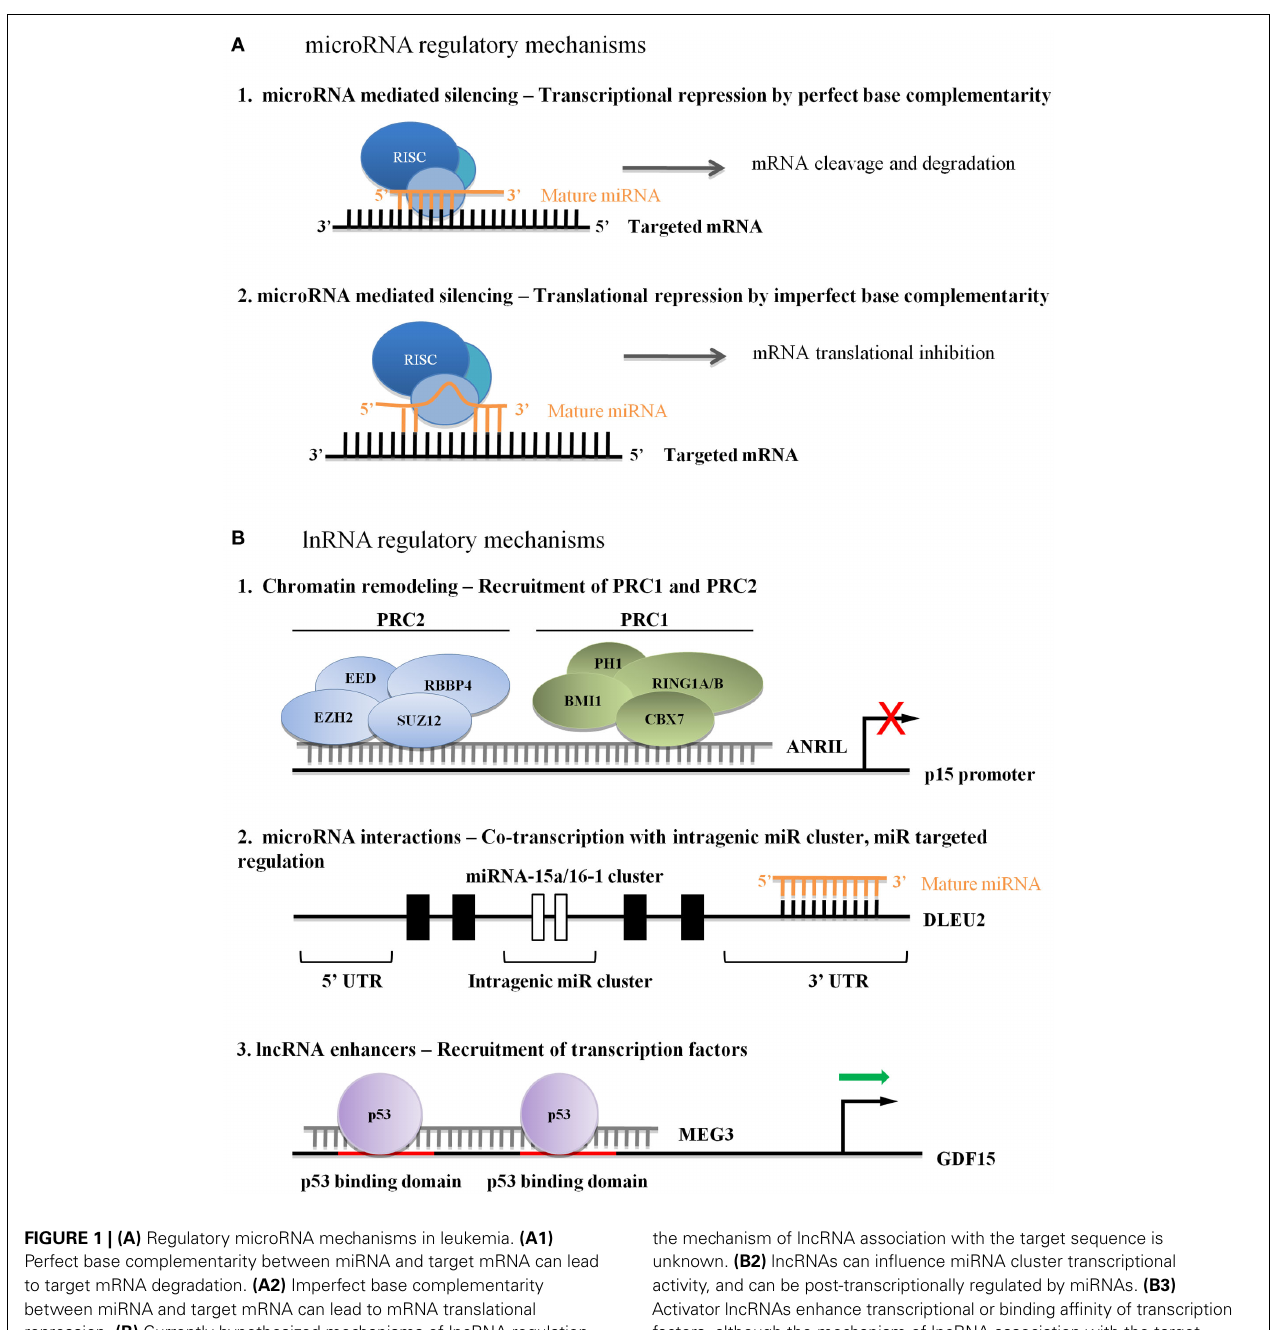
FIGURE 1 | (A) Regulatory microRNA mechanisms in leukemia. (A1) Perfect base complementarity between miRNA and target mRNA can lead to target mRNA degradation. (A2) Imperfect base complementarity between miRNA and target mRNA can lead to mRNA translational repression. (B) Currently hypothesized mechanisms of lncRNA regulation in leukemia. (B1) Recruitment of PcGs leads to stable repression, although